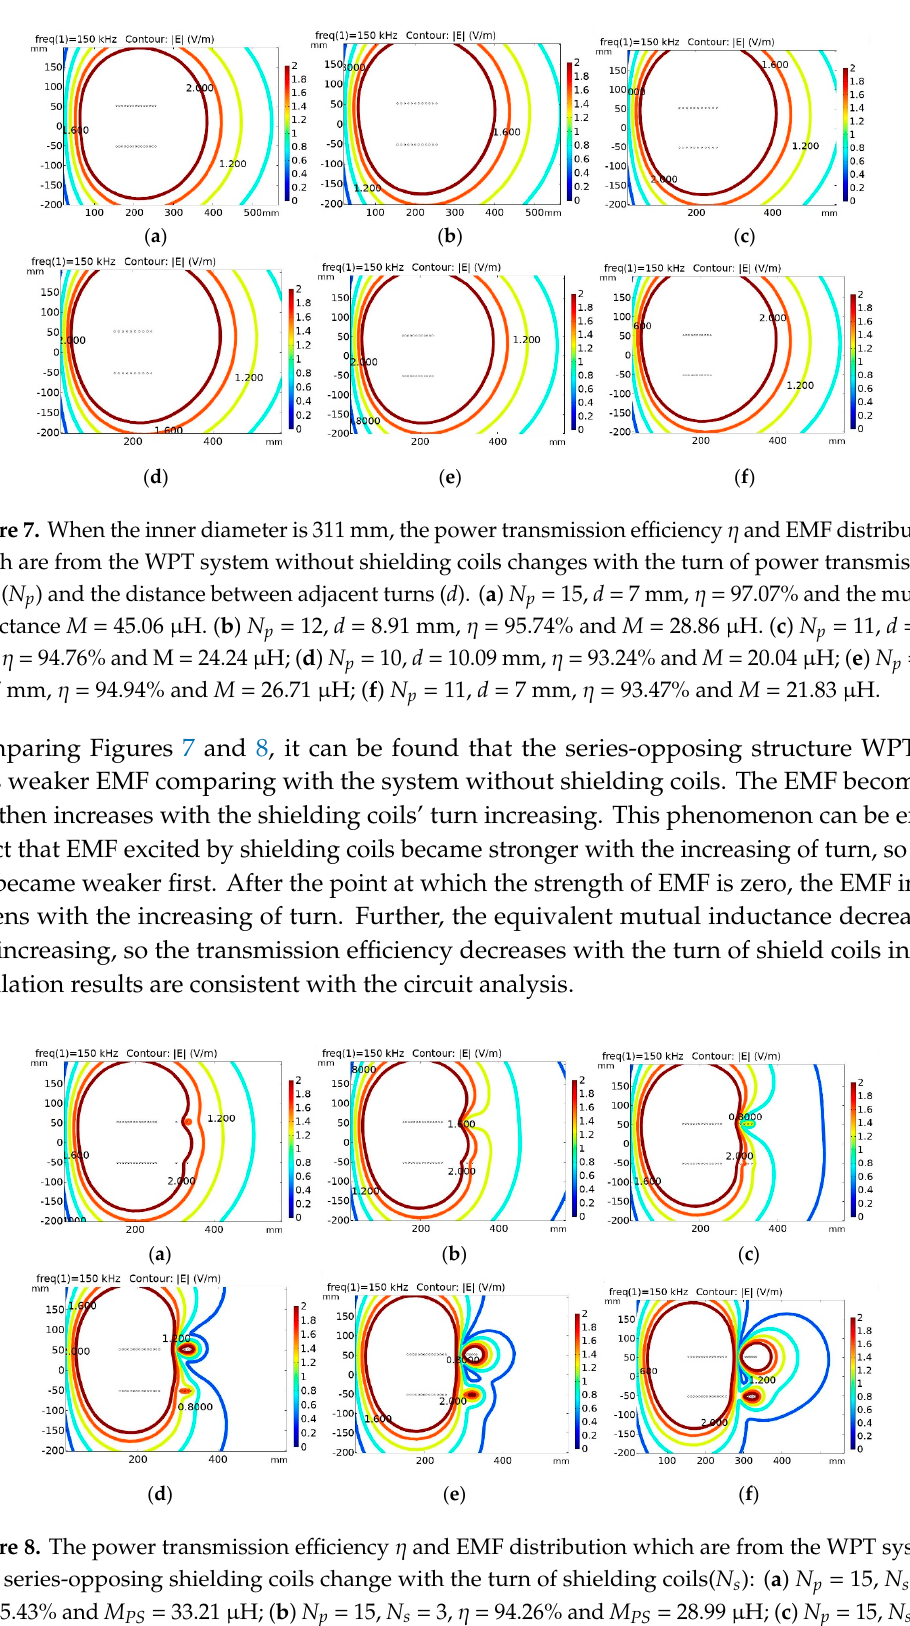
= 33.21 µ H; ( b ) N PS = 25.56 µ H; ( d ) N PS = 22.01 µ H; ( f ) N PS